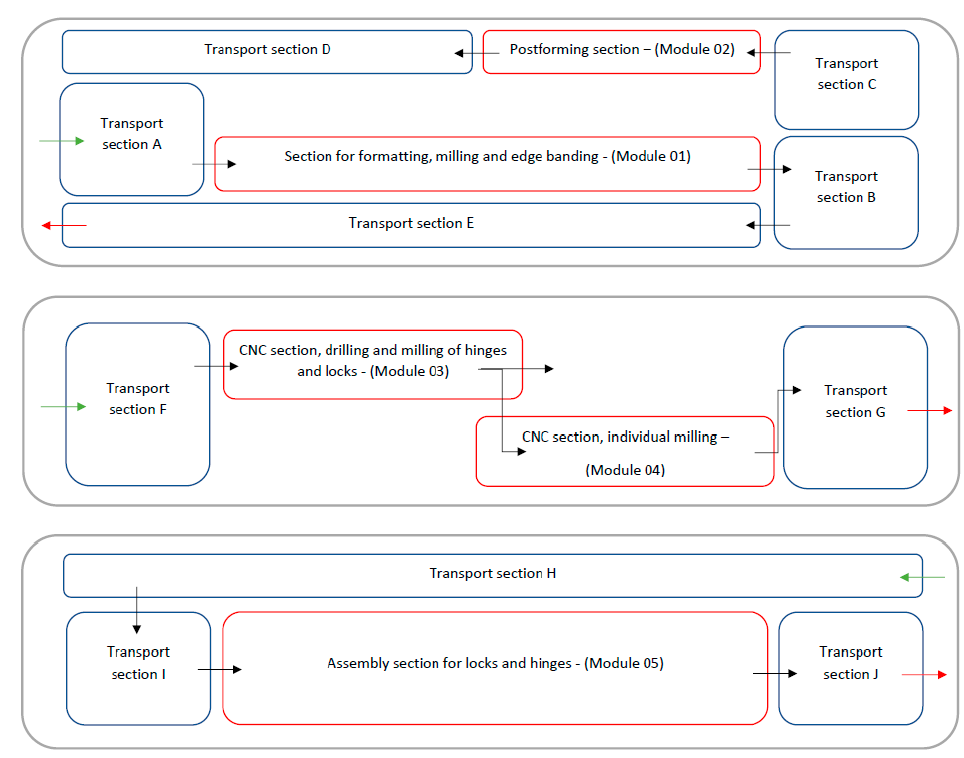
Figure 1. Schematic setup of the TechnoPORTA technological line.